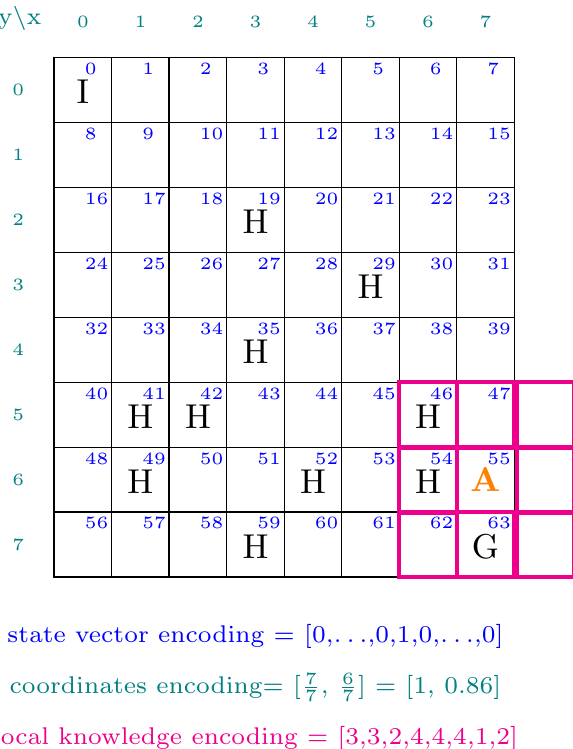
Table 1. An overview of the values for the different types of tiles in the LKE state encoding. Tile Type Value initial state 0 final state 1 frozen 2 hole 3 out of state space 4 A graphical illustration of the different encodings can be observed in Figure 4. 3 4 5 6 7